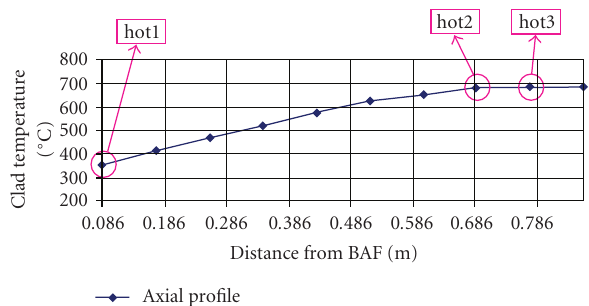
Figure 11: Temperature axial profile (Steady State—Hot Channel) with the points selected for the CFD simulations identified.